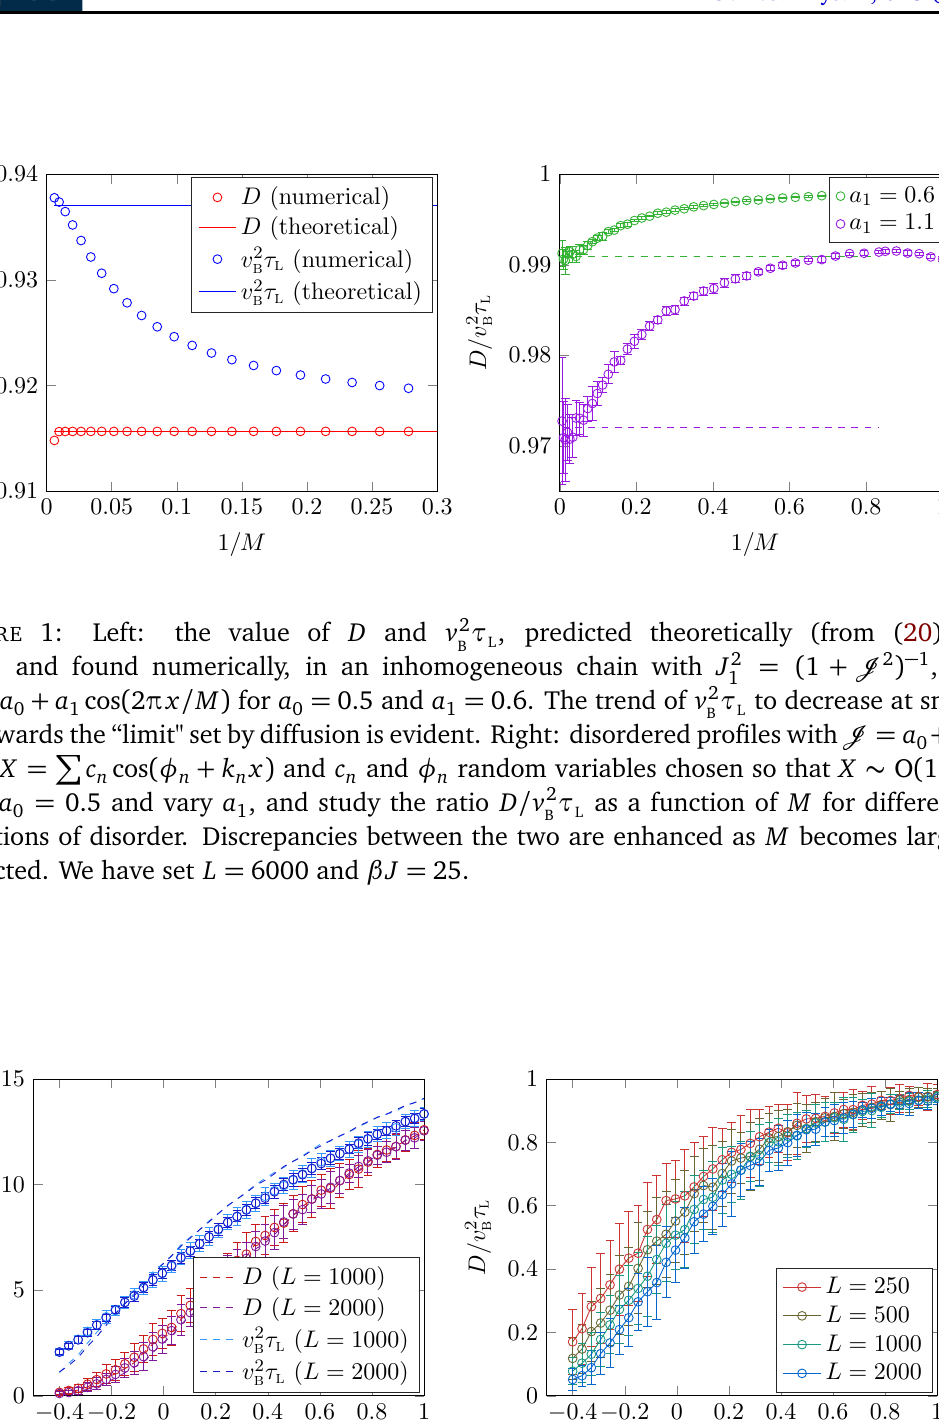
τ F IGURE 2: Left: Comparison of D and v 2 as a function of a , for chains where J 2 are i.i.d. L 1, x B < X ) = X 1 + a Θ ( X ) . The circular data random variables drawn from the distribution P ( J 2 1, x points with error bars are numerical data, and dashed lines are the mean of the hydrodynamic predictions for each chain. Qualitative agreement is observed. Right: the numerically com- τ puted ratio D / v 2 as a function of a . We see that this ratio rapidly drops for a (cid:174) 0, as finite L B size effects become appreciable. This data is taken at β J =